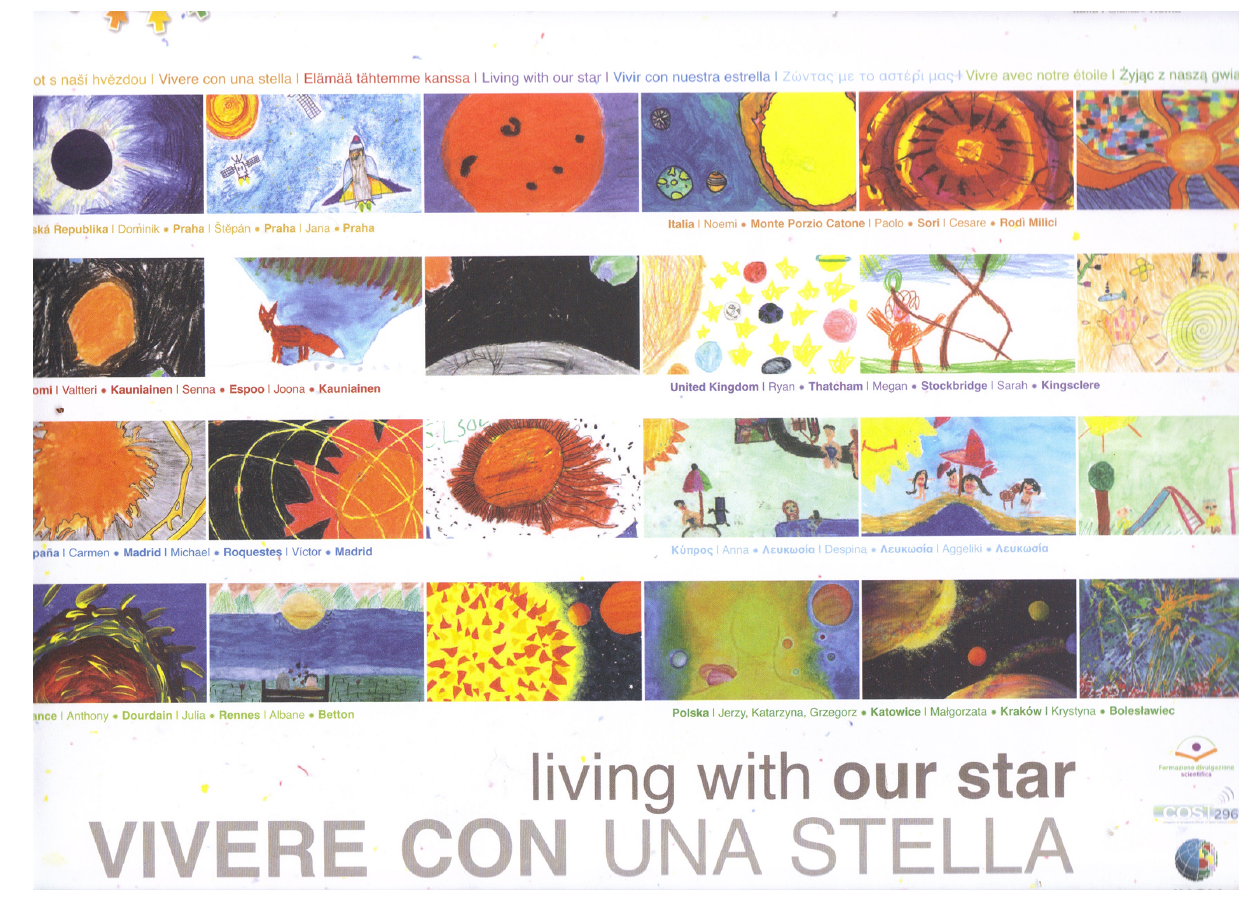
Figure 2. The back cover of the 2007–2008 calendar dedicated to the Sun and realized, through a partnership of European countries in the COST269 project, in eight languages (edited by INGV Settore Formazione e Divulgazione Scientifica and INGV Laboratorio Grafica e